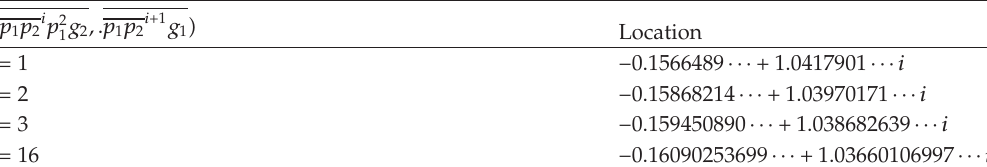
Table 3: Location of canonical double-spiral medallions.